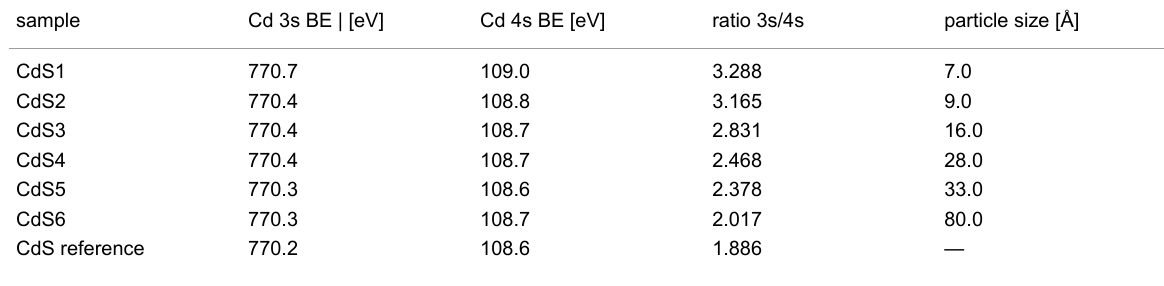
Table 1: Binding energy and peak area ratio of Cd 3s and Cd 4s used for the Davis model.